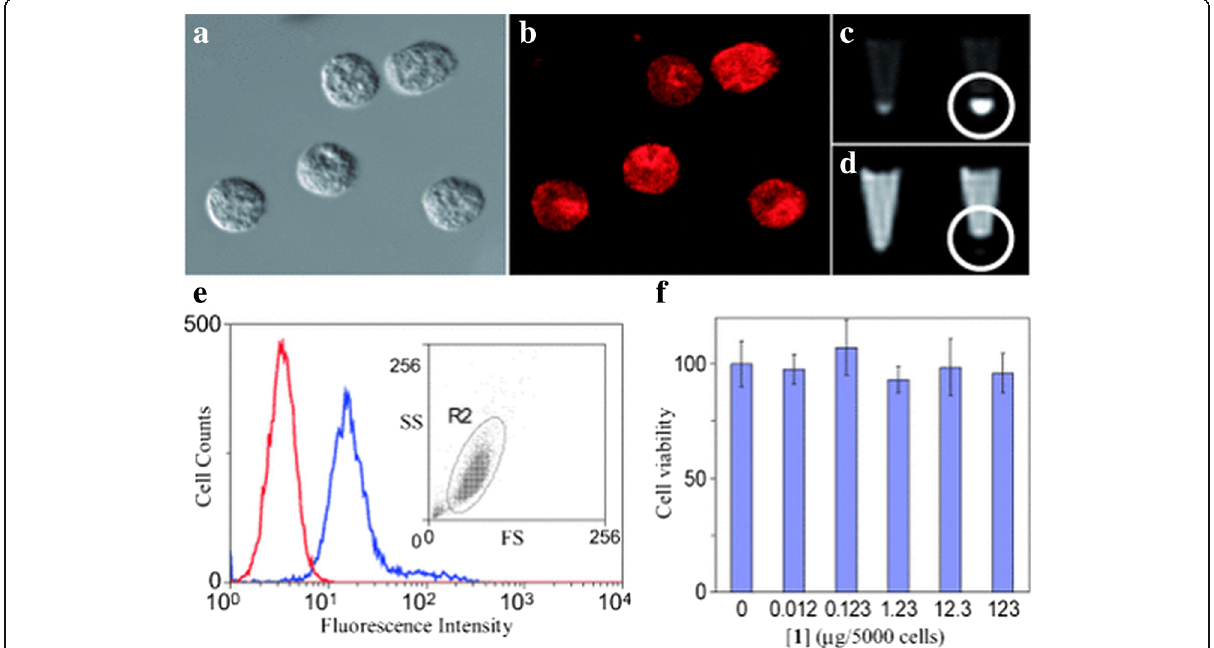
Fig. 15 The imaging results of monocyte cells with a optical microscopic, b laser scanning confocal fluorescence, c , d the images of monocyte cells with MR: left for unlabeled monocyte cells and right for hybrid silica nanoparticles labeled monocyte cells, e flow cytometric results of blank and hybrid silica nanoparticles-labeled monocyte cells, and f the cell viability with different amount of hybrid silica nanoparticles [39]